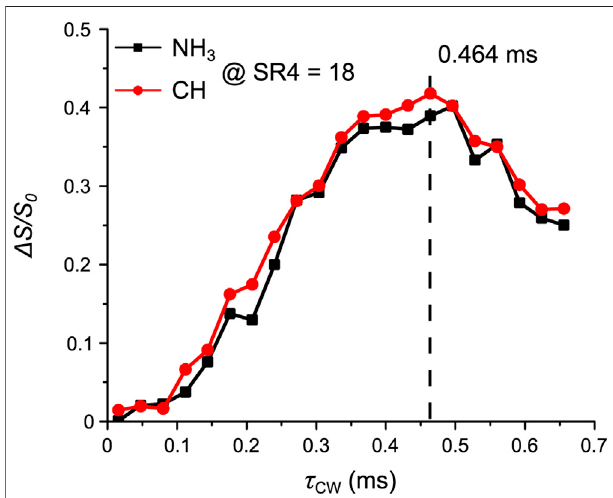
FIGURE6| Tyr:thesignalfraction Δ S / S H 3 (blacksquares)andC H 0 ofN (red circles) as a function of τ CW . Experiments were performed at τ mix of 1.15 ms. The optimum τ CW is shown and highlighted by the dashed line. Further experimental details are given in the Experiments section.